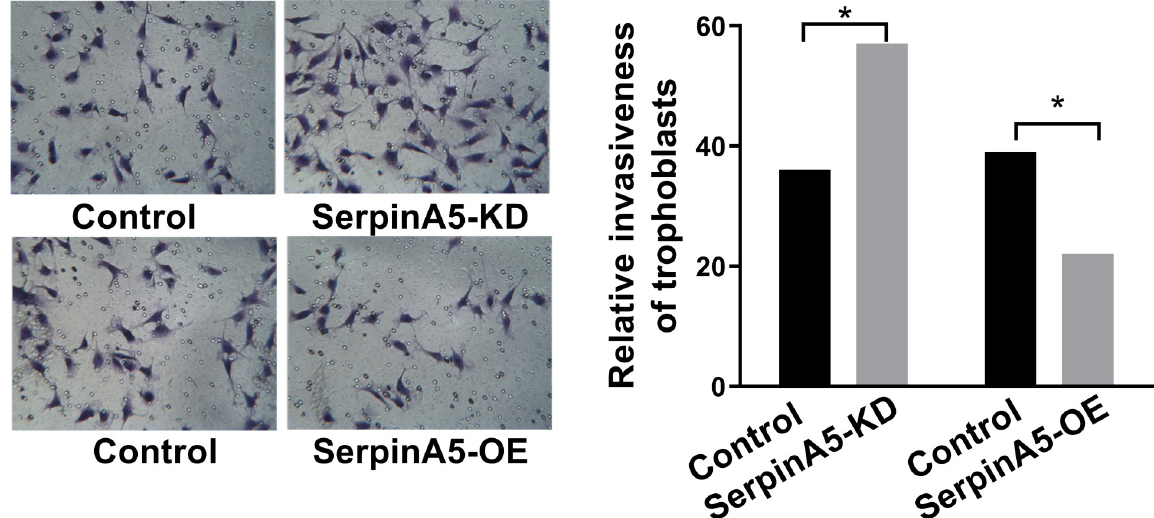
Fig 4. In vitro invasion analysis. Over expressed SerpinA5 could inhibit the invasion of trophoblasts; knockdown SERPINA5 could enhance invasion of trophoblasts.